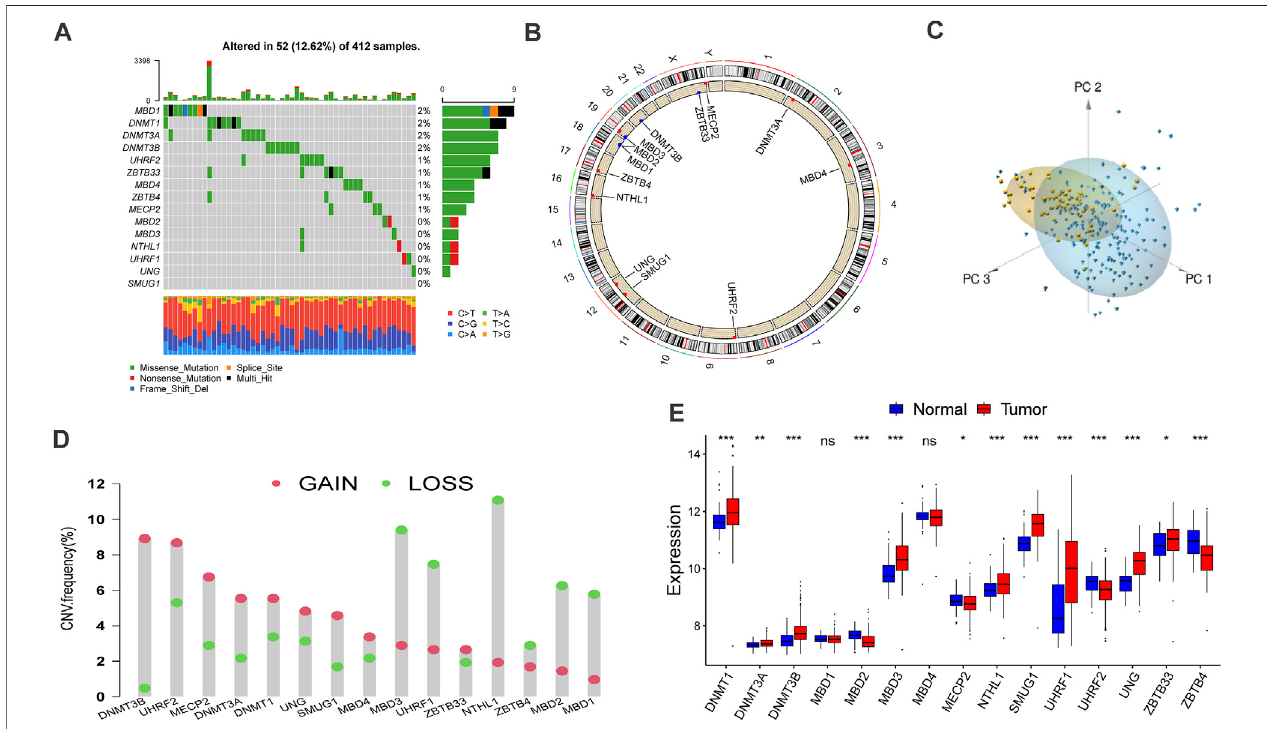
FIGURE 1 | Landscape of genetic alteration and transcriptome variation of DNA methylation regulators in bladder cancer. (A) The alteration frequency of 15 DNA methylation regulators in 412 bladder cancer samples (TCGA-BLCA). the annotation of each variant types was displayed by the bagplots right barplots. Each cohort represented an individual sample. The stacked barplot below displayed conversion ratio for each sample. (B) The location of CNV alteration of DNA methylation regulatorson 23chromosomes wasdisplayed bycircularplot. (C) Principalcomponentanalysis(PCA) forthetranscriptomecharacteristicsof15DNAmethylation regulators to distinguish tumors from normal samples in GSE13507 cohort. Tumor samples were labeled with blue color and normal samples were labeled with yellow. (D) The frequencyofcopy number variationinTCGA-BLCAcohort. Deletion frequency: thegreendotand ampli fi cation frequency: red dot.The number representedthe variation frequency. (E) The transcriptome characteristics of 15 DNA methylation regulators between normal and bladder cancer tissues. Tumor: red box; Normal: blue box. The median value: black lines in boxes, the outliers: black dots out boxes. The asterisks represented the statistical p value (* p < 0.05; ** p < 0.01; *** p < 0.001).